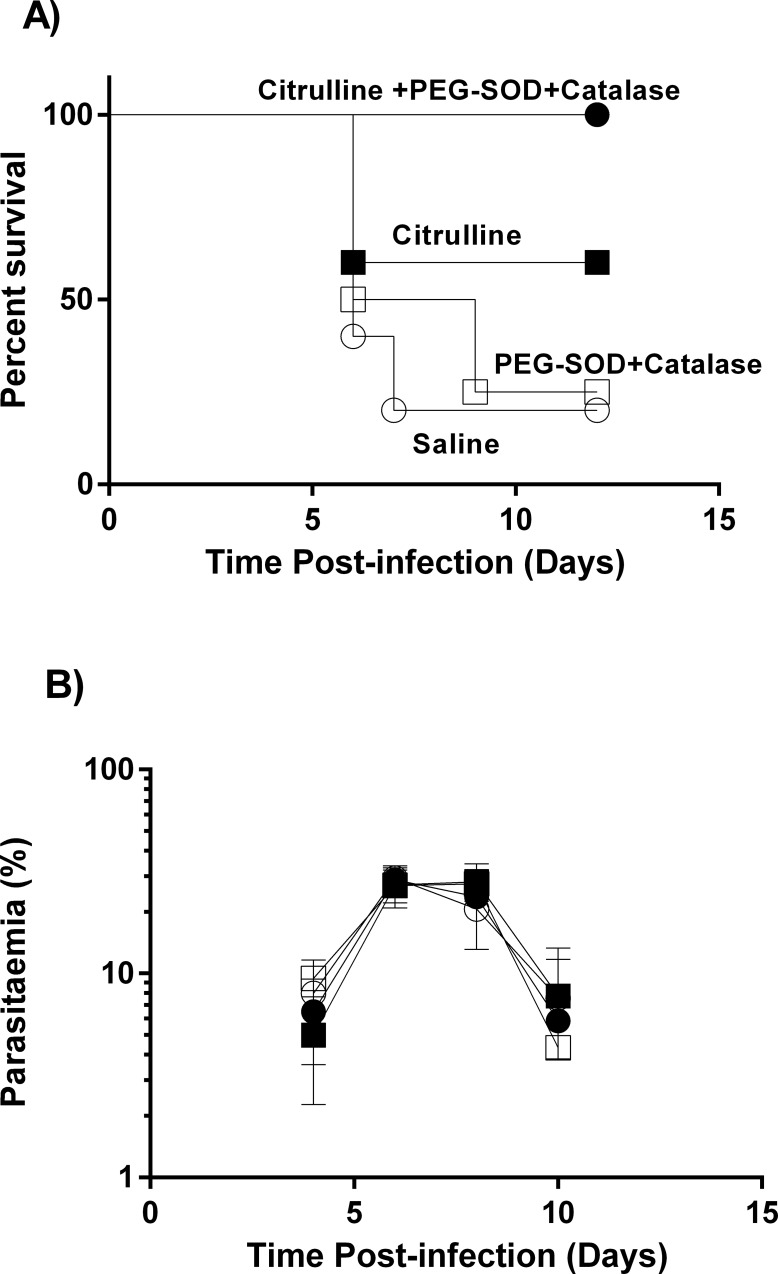
Citrulline plus SO scavenging by PEG-SOD+PEG-CAT provides complete protection.Four groups (n = 5) of mice were injected i.v. with PbA. (A): survival, (B): parasitemia (mean % ± stderr) timecourse of the groups of mice injected with (i) citrulline, (ii) PEG-SOD+PEG-CAT, (iii) citrulline plus PEG-SOD+PEG-CAT, or (iv) saline from day 4 PI with quinine drug rescue on day 6PI. This experiment was repeated with similar results.